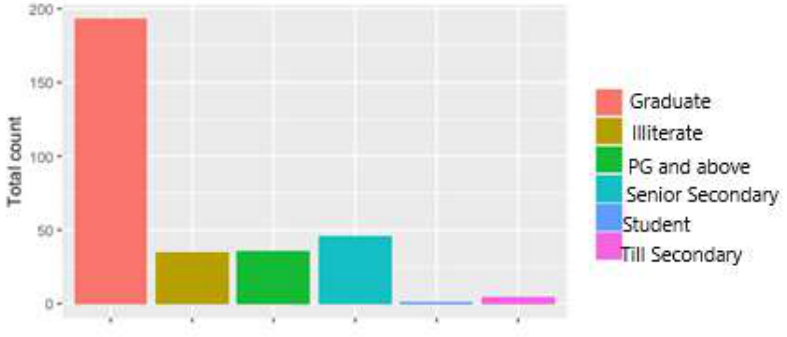
Figure 5: Educational Qualifications of Respondents ( Source: Authors‟ depiction